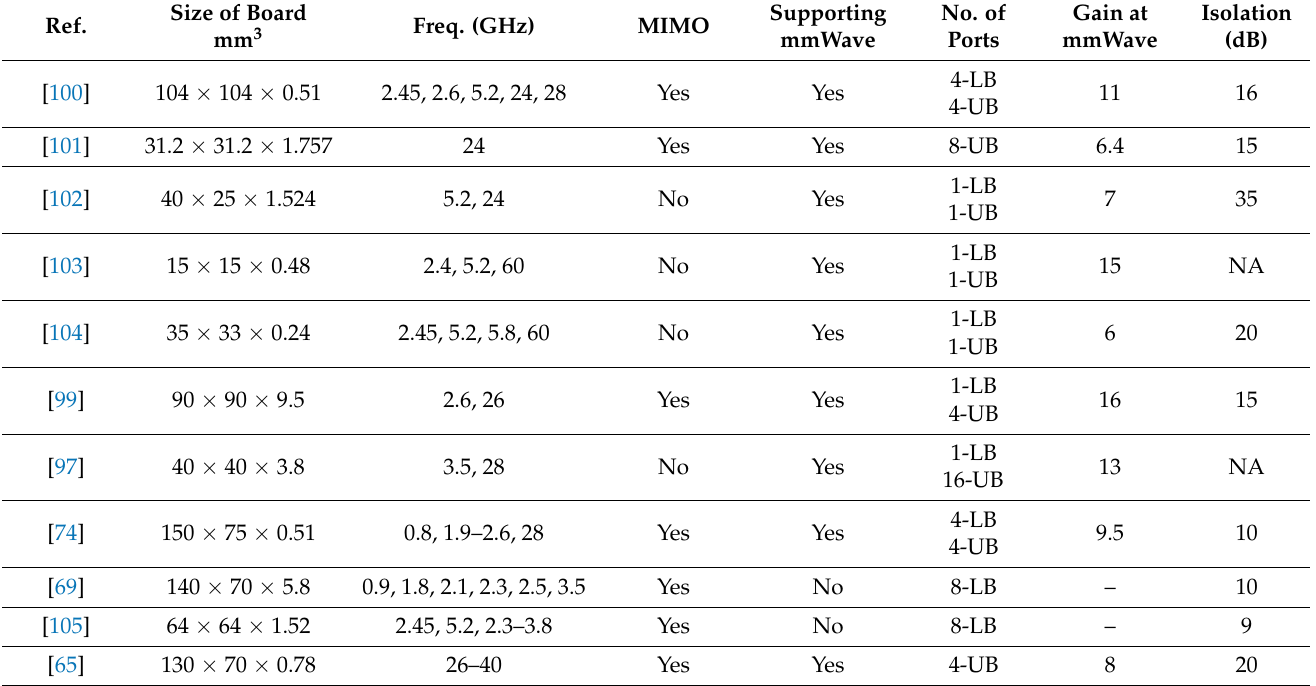
Table 4. Comparison between 5G antennas according to the operating